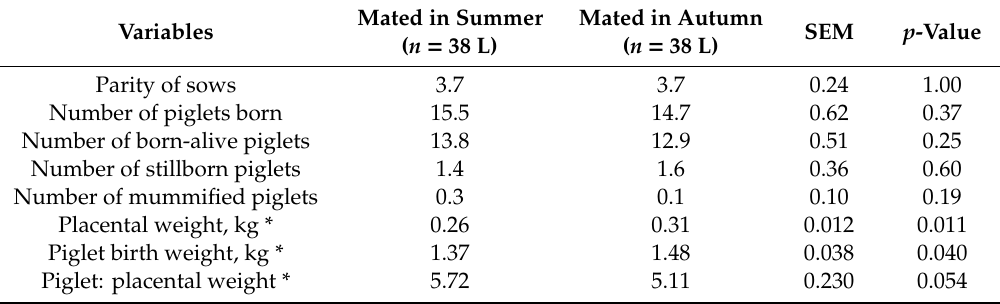
Table 3. Placental weight of focal sows mated in summer vs.